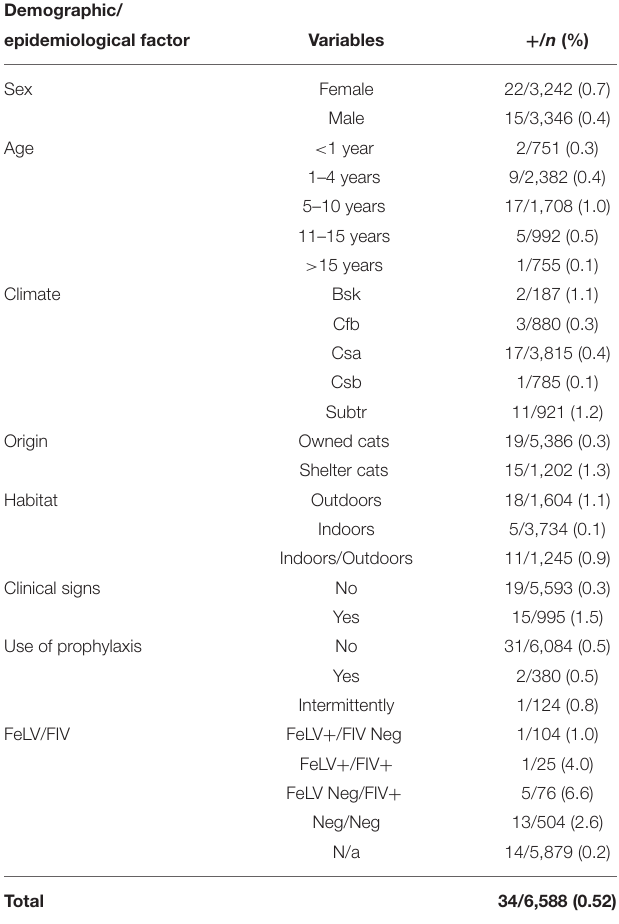
TABLE 4 | Prevalences for antigens of D. immitis in cats in Spain by sex, age, climate, origin, habitat, presence of clinical signs, use of prophylaxis and FeLV/FIV